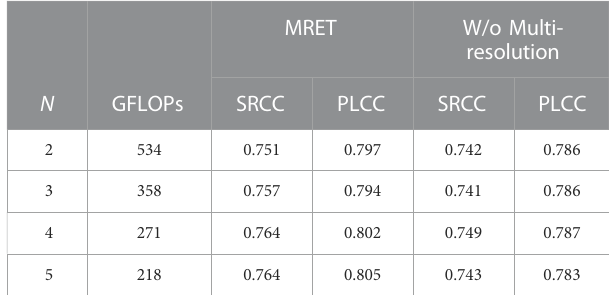
TABLE 5 Ablation study results for number of grouped frames N on the LSVQ- 1080p dataset. MRET uses multi-resolution input while “ w/o Multi-resolution ” use fi xed resolution frames. Models here are trained with 60 input frames instead of